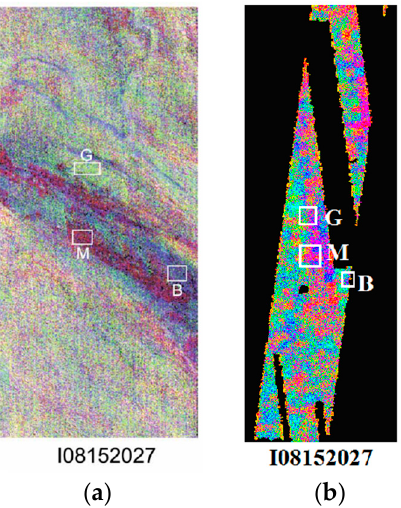
Figure 21. Areas of interest-Decorrelation Stretch of bands 5, 7, and 8 as presented in Rogers [80] ( a ). Decorrelation Stretches of pansharpened area of study images ( b ).